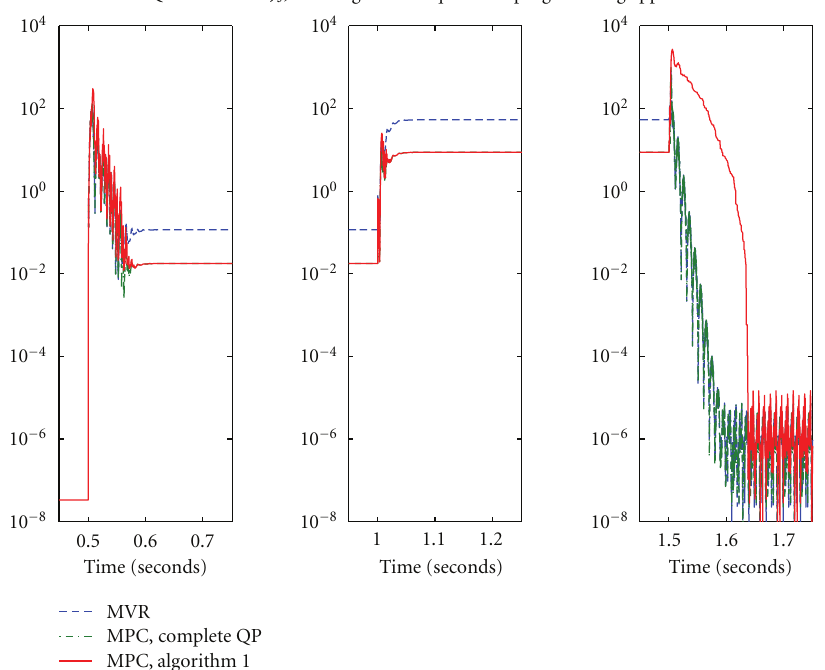
Figure 3: Quadratic cost J s of the steady-state subproblem, the receding horizon quadratic programming approach.